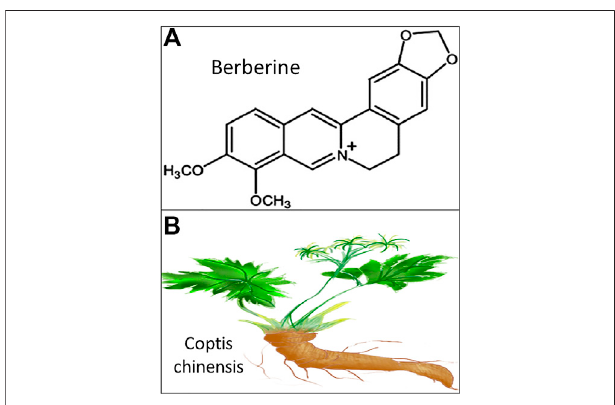
FIGURE 1 | Schematic illustration of berberine. (A) . Chemical structure of berberine retrieved from National Center for Biotechnology Information https://pubchem.ncbi.nlm.nih.gov/compound/berberine; (B) . Herbal plant of Chinese medicine Coptis